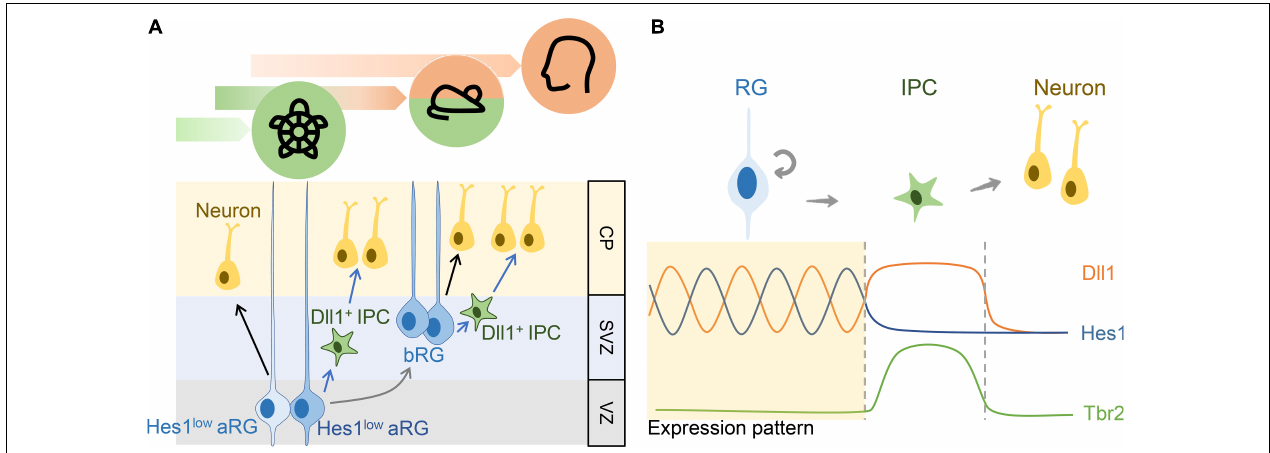
FIGURE 3 | The role of Notch signaling in the balance between self-renewal and differentiation in the neural progenitors. (A) The schematic diagram showing the direct (black arrows) or indirect modes (blue arrows) of neurogenesis and the expression of Notch signaling components in the developing turtle, mouse, and human cortex. (B) The schematic diagram showing the dynamic expression pattern of key factors, Hes1 and Dll1, in Notch signaling and IPC gene Tbr2. The upregulation of Tbr2 follows the sustained Dll1 expression and the downregulation of Hes1